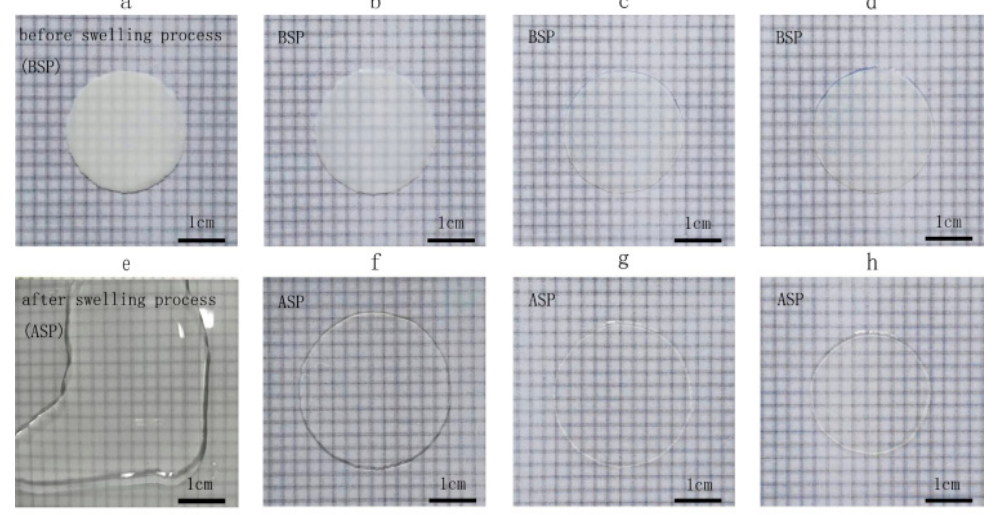
Figure 4. The form of the membranes before ( a – d ) and after ( e – h ) swelling. ( a , e ) CM-0; ( b , f ) CM-0.4; ( c , g ) CM-0.8; and ( d , h ) CM-1.2.